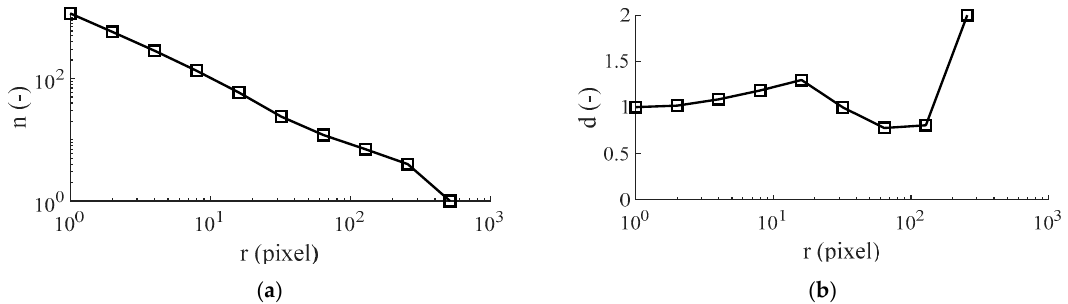
Figure 2. Process of image analysis for determination of fractal dimension: ( a ) cross-section, ( b ) binary image, ( c ) interface line, and ( d ) box-counting algorithm.